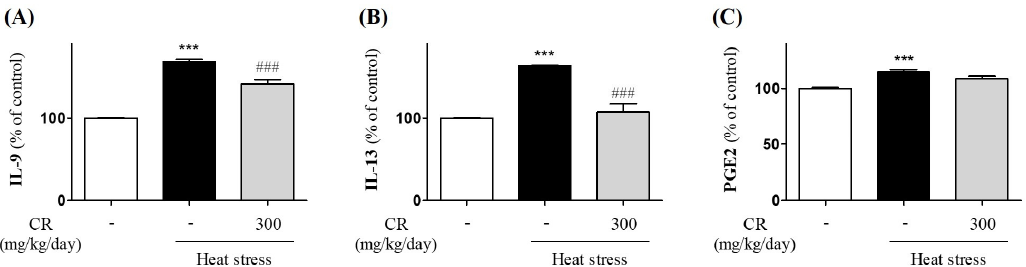
Figure 4. Effects of CR on the elevated release of IL ‐ 9, IL ‐ 13, and PEG2 in hypothalamus of mice after heat exposure. In hypothalamus of mice after heat exposure, the presence of cytokines was determined using sandwich ELISA kit. ( A ) The release of IL ‐ 9 was significantly increased after heat exposure, however, but 300 mg/kg of CR significantly reduced the heat stress ‐ induced elevation of IL ‐ 9. ( B ) The production of IL ‐ 13 was elevated under heat ‐ stress conditions, whereas the treatment of CR significantly decreased the elevated level of IL ‐ 13. ( C ) In the hypothalamus of mice, the presence of PGE2 was determined using sandwich ELISA analysis. Values are expressed as means ± SEM. *** p < 0.001 as compared with the control group. ### p < 0.001 as compared with the heat ‐ exposed vehicle ‐ treated group.